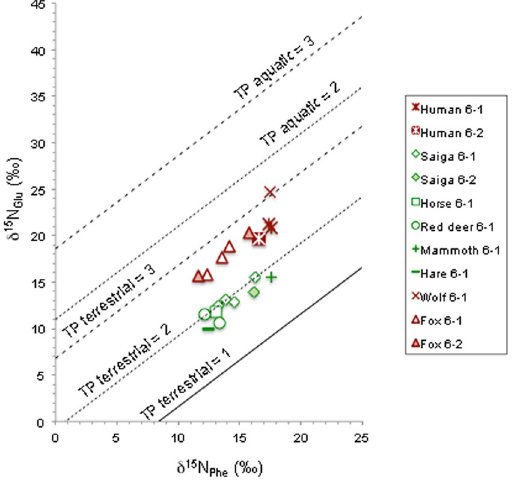
Figure 3. Measured δ 15 N Phe and δ 15 N Glu values on saiga, horse, red deer, mammoth, hare as herbivores and wolf, fox and human remains from layers 6-1 and 6-2 of Buran-Kaya III. Solid, dotted, and dashed lines indicate theoretical lines for δ 15 N Phe and δ 15 N Glu values of organisms with TP (Trophic Position) in terrestrial ecosystem = 1, 2, and 3, and aquatic ecosystem = 2 and 3,